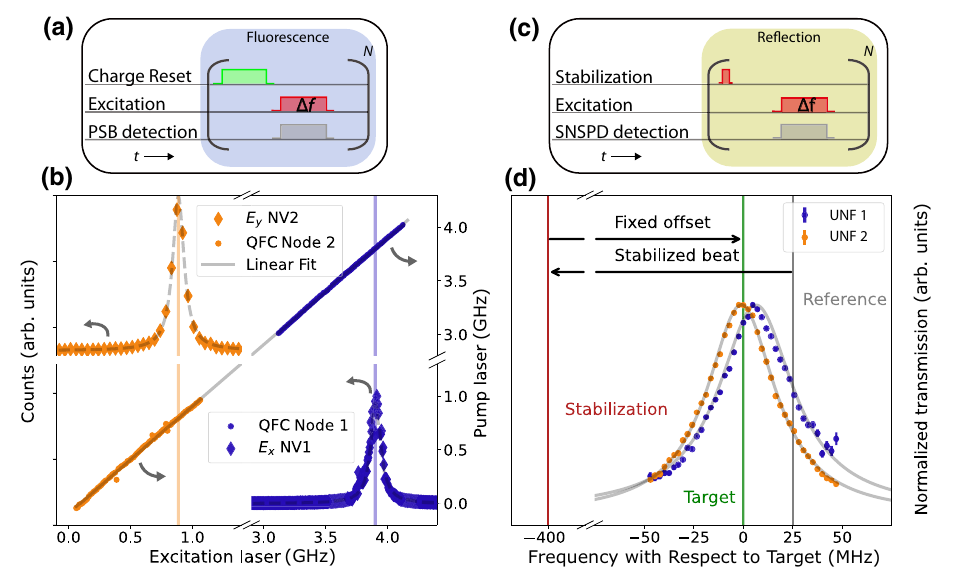
FIG. 2. The removal of spectral offset using conversion. (a) The fluorescence measurement sequence used in (b). A charge-reset pulse is followed by repeated resonant excitation, during which fluorescence in the PSB is monitored. (b) Resonant excitation spectra at node 1 (node 2) shown in blue (orange) diamonds, revealing the frequencies of the optical transitions (vertical lines) used for photon generation. The horizontal axis shows the optical excitation frequency with respect to a 470.477-THz offset. The gray dotted lines are Lorentzian fits. The right vertical axis shows the frequency of the QFC pump with respect to a 281.635-THz offset. The blue and orange dots show the QFC pump-laser frequency when the stabilization is active. The solid gray line is a linear fit. (c) A pulse schematic for measuring the transmission through the ultranarrow filter (UNF) shown in (d). Reflections from the excitation light off the sample surface, which follow the same path as the resonant NV emission, are converted to the target telecom frequency and measured on the SNSPDs. The excitation frequency is swept by modulating the AOM frequency [see Fig. 1(c)]. The transmission data are corrected for the frequency dependence of the losses in the AOMs. (d) The layout of relevant laser frequencies and the transmission data of the UNFs. The UNF transmissions (blue and orange dots) are actively stabilized via their temperature to half the transmission of the reference laser (gray vertical line). The stabilization light (red vertical line) is detuned from the target (green vertical line) and therefore reflected off the UNF (see main